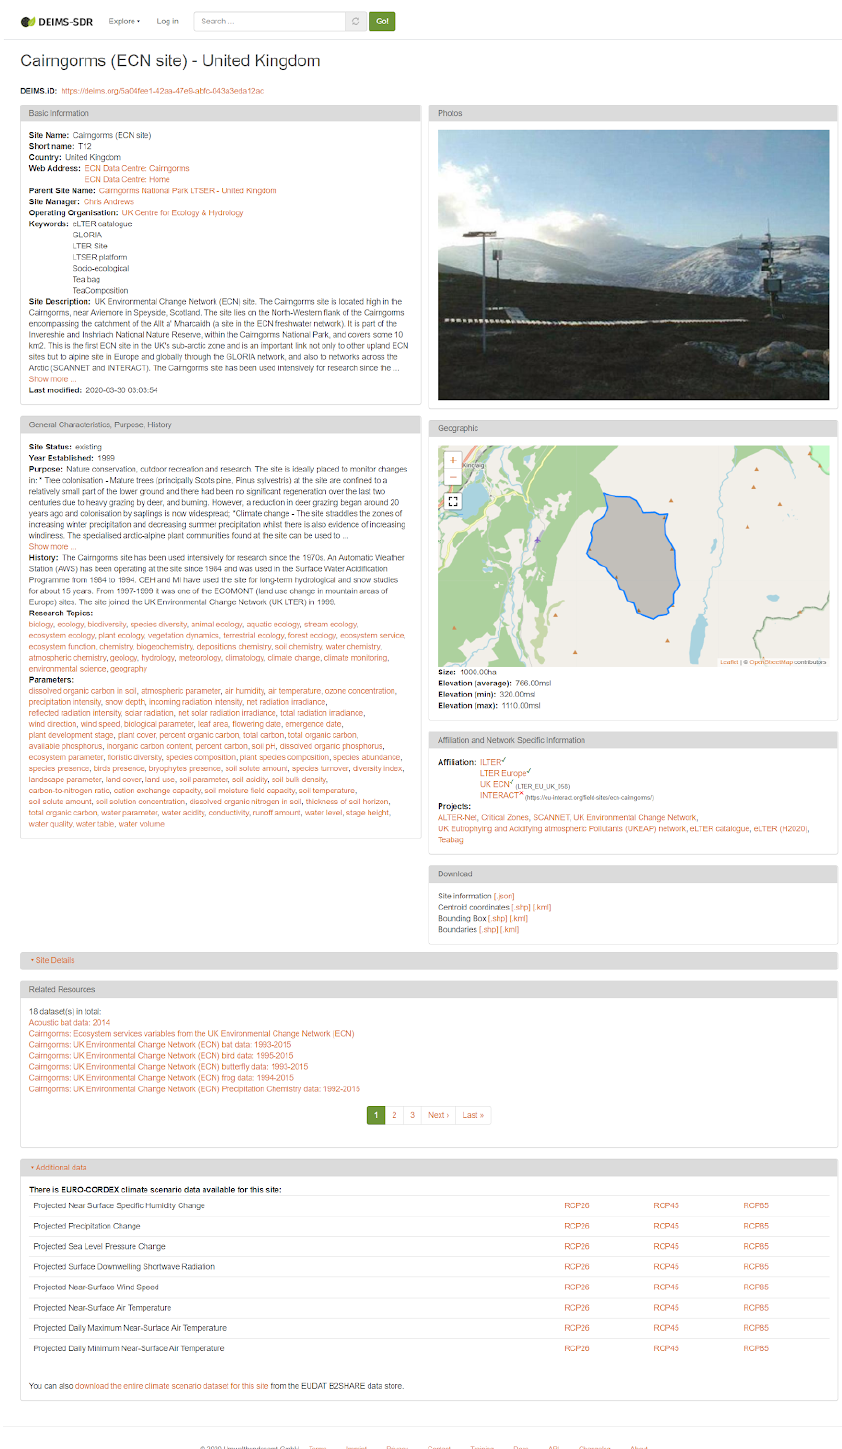
Figure 5. DEIMS-SDR metadata viewer with the access to the climate information at the bottom.